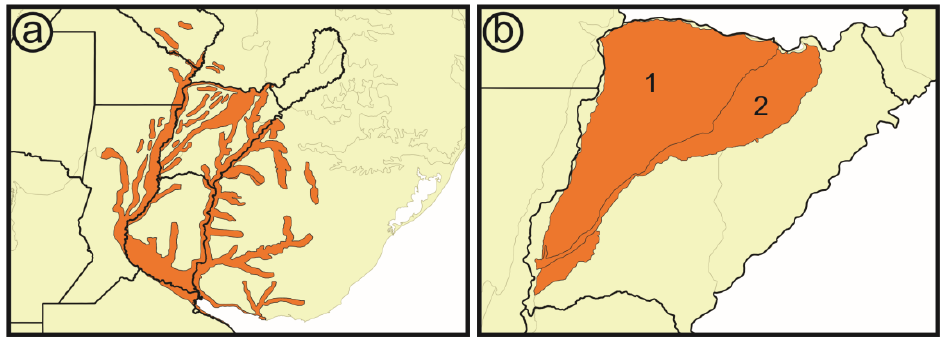
Figure 3. ( a ) Esteros del Iberá province sensu Morrone et al. [22], ( b ) Esteros del Iberá ecoregion sensu Brown and Pacheco [18]: 1: Parque Chaqueño Correntino ; 2: Iberá .